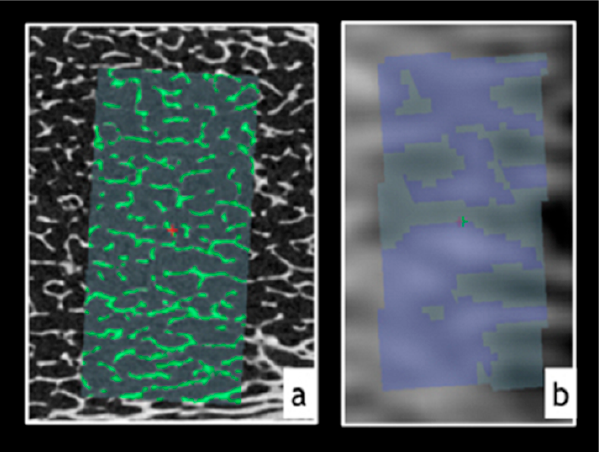
Figure 1. Determination of volume of interest (VOI). ( a ) From right to left: Axial, coronal, and sagittal cuts of microcomputed tomography ( µ CT) images. ( b ) Using reference lines, perforation midcenter was determined. and VOI was segmented.